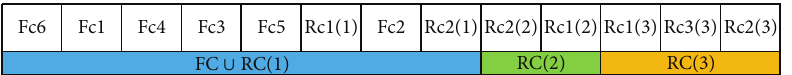
Figure 6: Placement-mapping chromosome coding for GA.